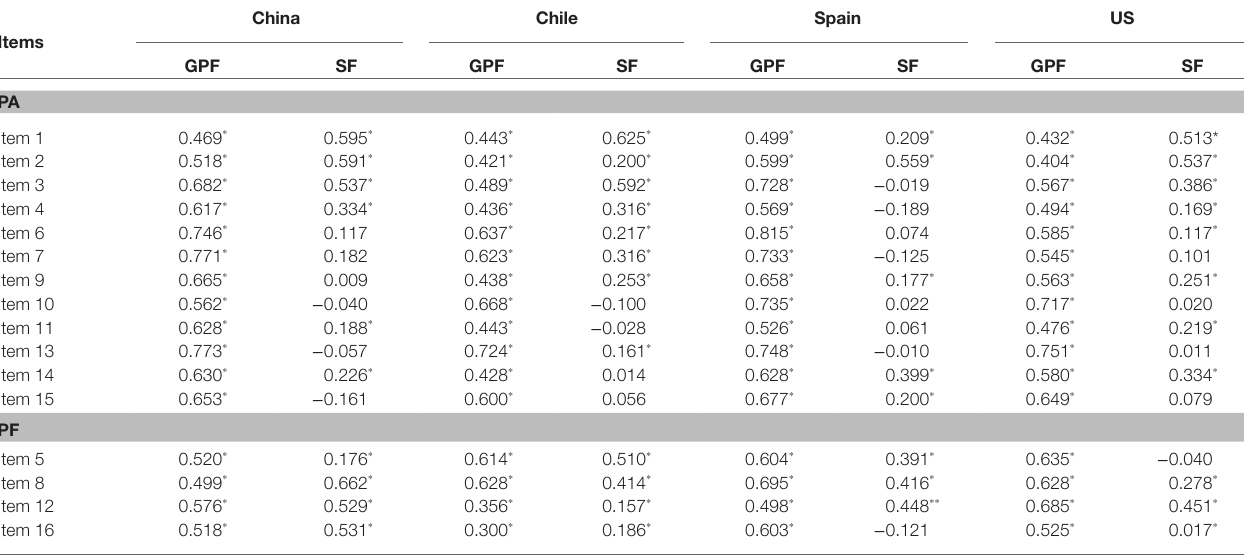
TABLE 5 | Standardized factor loadings in the bifactorial model from CFA of the Prosociality Scale separately for the countries.